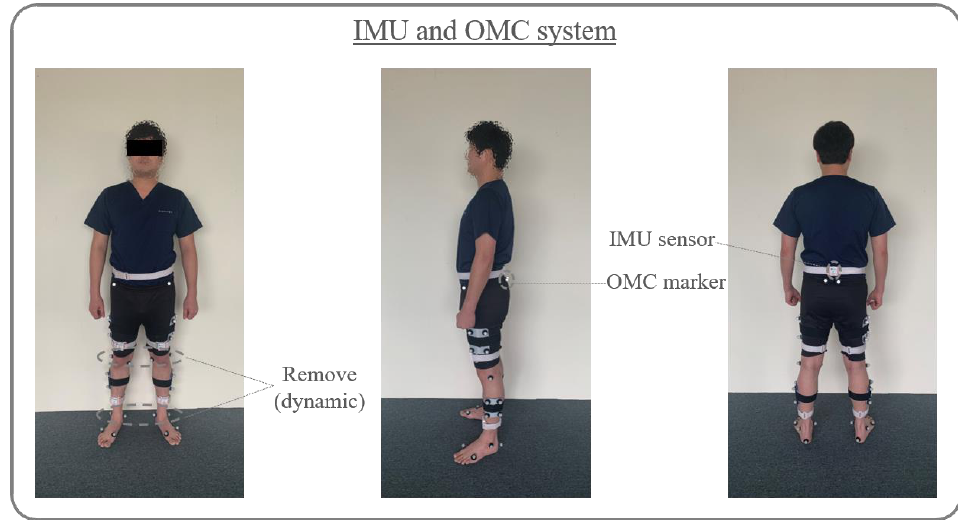
Figure 1. Sensor and marker positions in the inertial measurement unit (IMU) and optical motion capture (OMC) systems.